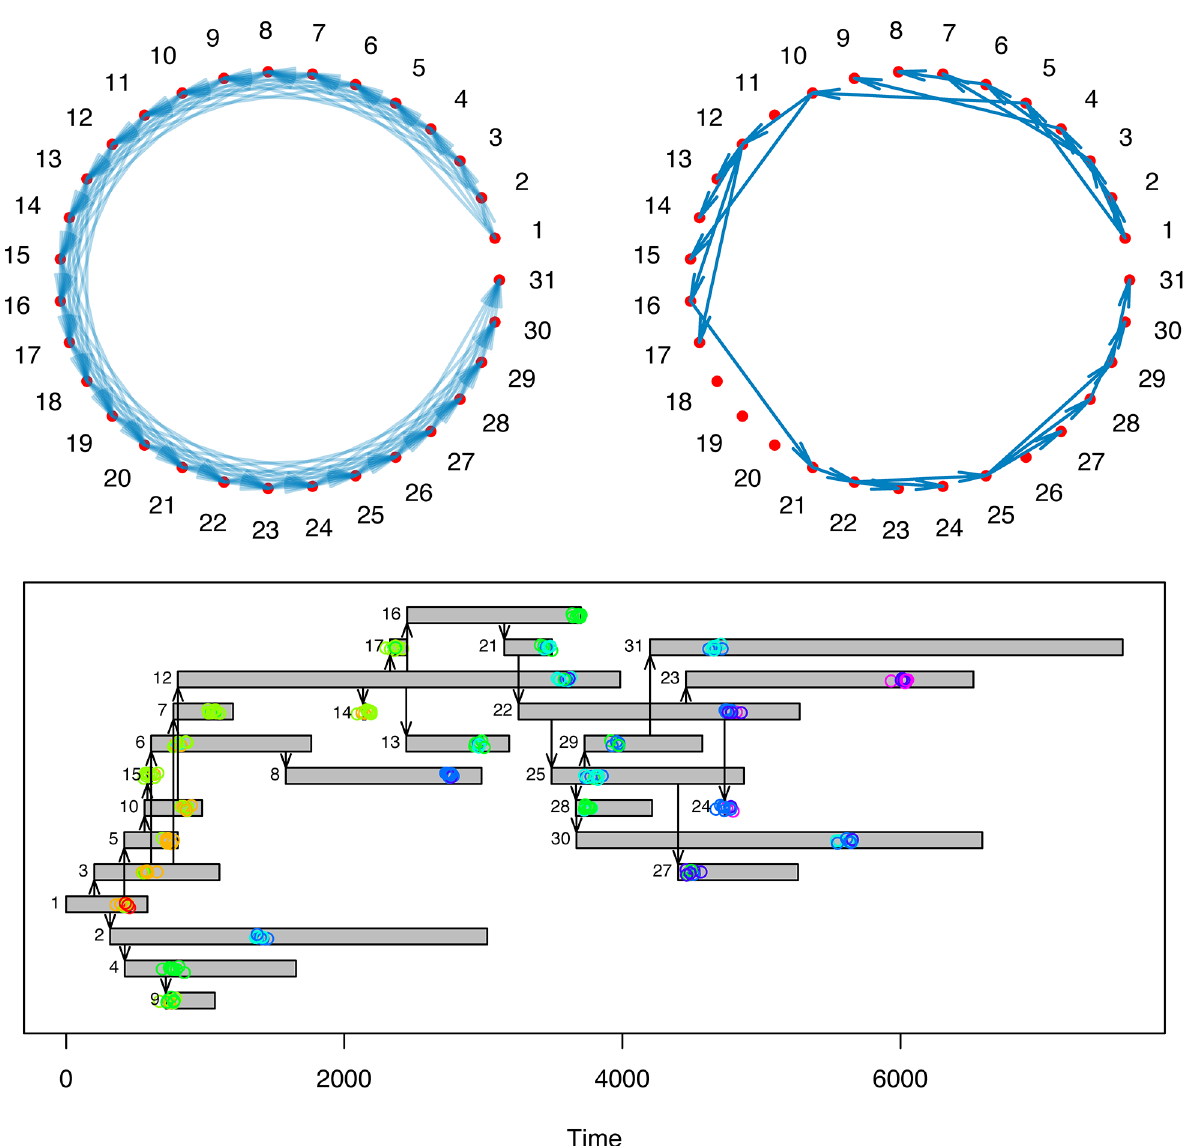
Fig 4. Simulated epidemic and genomic sampling in a heterogeneously-mixing population. (A) The contact network of the population, individuals represented by nodes, and contacts by directed edges. (B) Simulated routes of transmission (directed edges) in this population, where the disease is initially introduced in individual 1. (C) The outbreak and genomic sampling over time. Infected individuals are represented by gray rectangles spanning the time from infection to recovery, arrows denote routes of transmission. Every 250 time steps, ten genomes were sampled at random from each infected individual ’ s hosted pathogen population. Genomes are represented by colored circles, colored according to genetic distance from the first sampled genome in individual 1; red denotes an identical genotype, while colors closer to the blue end of the spectrum denote an increasing genetic distance from this reference genome.